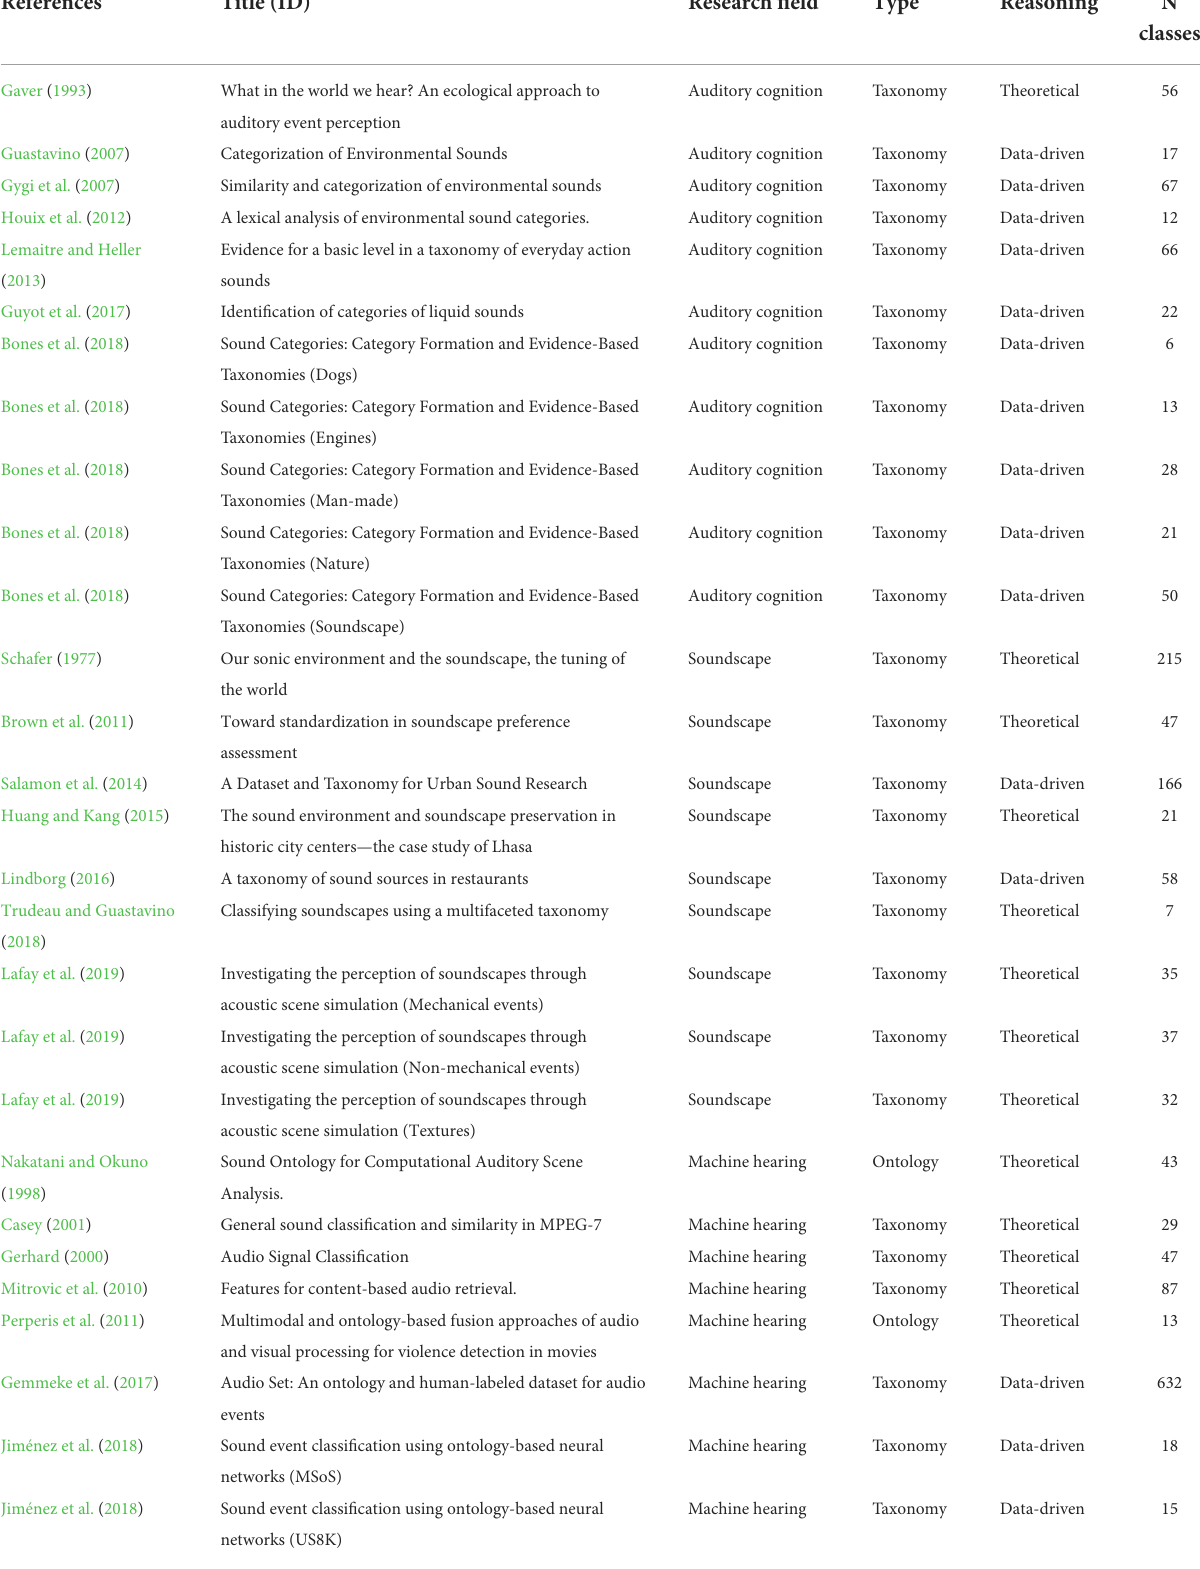
TABLE 1 Sound categorization schemes selected for this review, and their